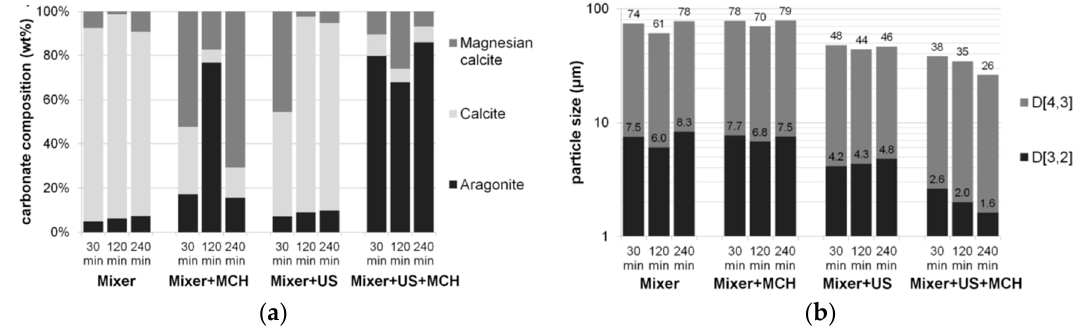
Figure 6. Carbonate composition ( a ) and mean particle diameters ( b ) of carbonated AOD slag using mixer-only, combination mixer/ultrasound, with and without MCH addition, as a function of the reaction time; results with varying MCH dosages were averaged to facilitate plotting [24]. Re-used with permission from Elsevier (4366260286557).